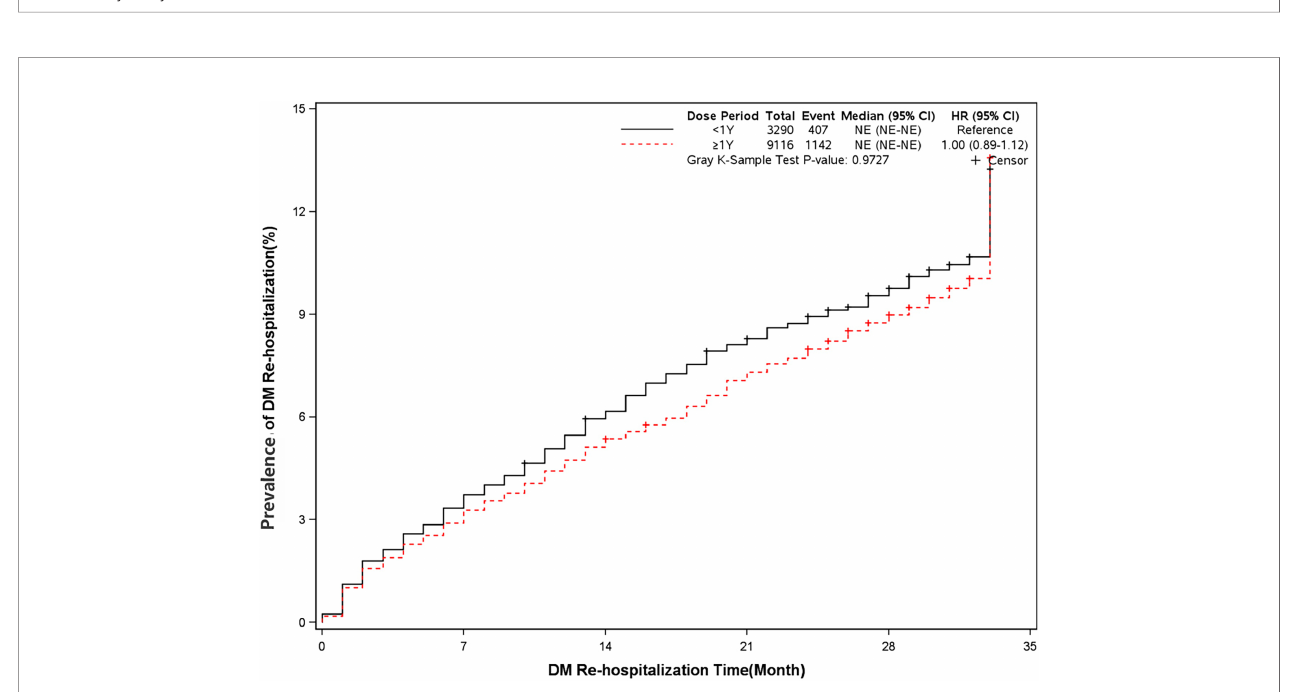
FIGURE 5 | Prevalence of diabetes-related rehospitalization in two groups. Blackline: patients took clopidogrel continuously 1 year; Red line: patients took clopidogrel continuously ≥ 1